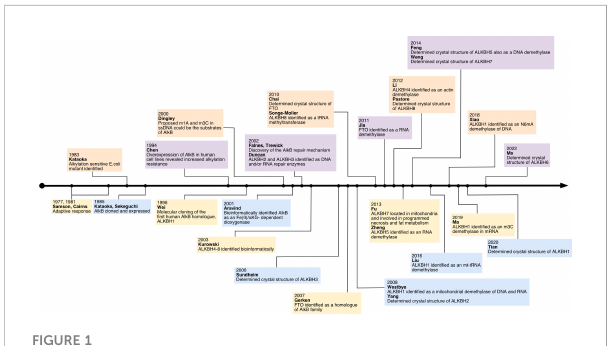
FIGURE 1 The history of research on human AlkB